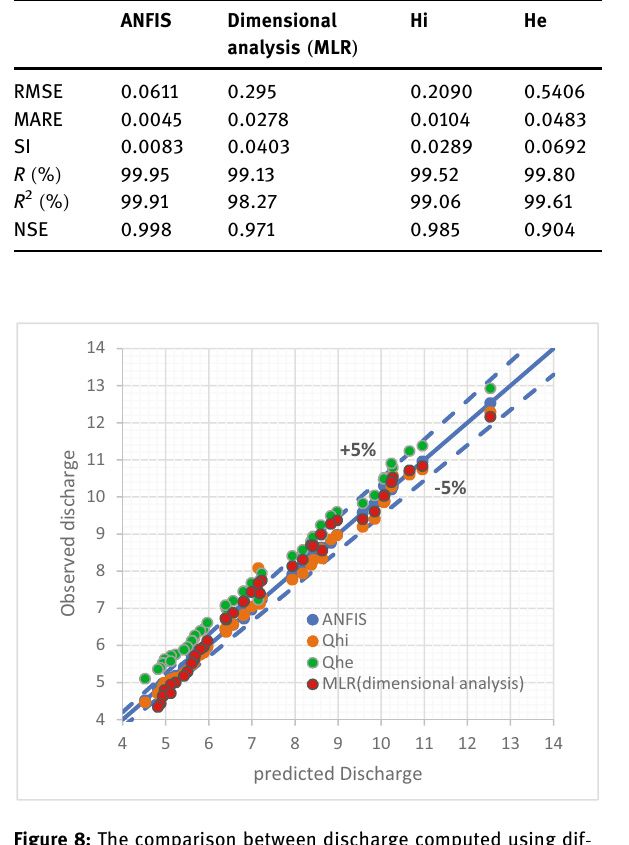
Figure 8: The comparison between discharge computed using dif - ferent